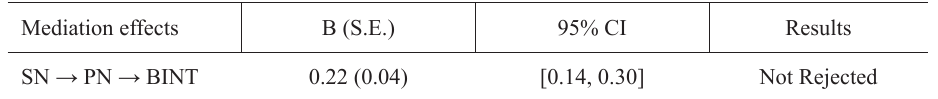
Table 8. Result of mediation